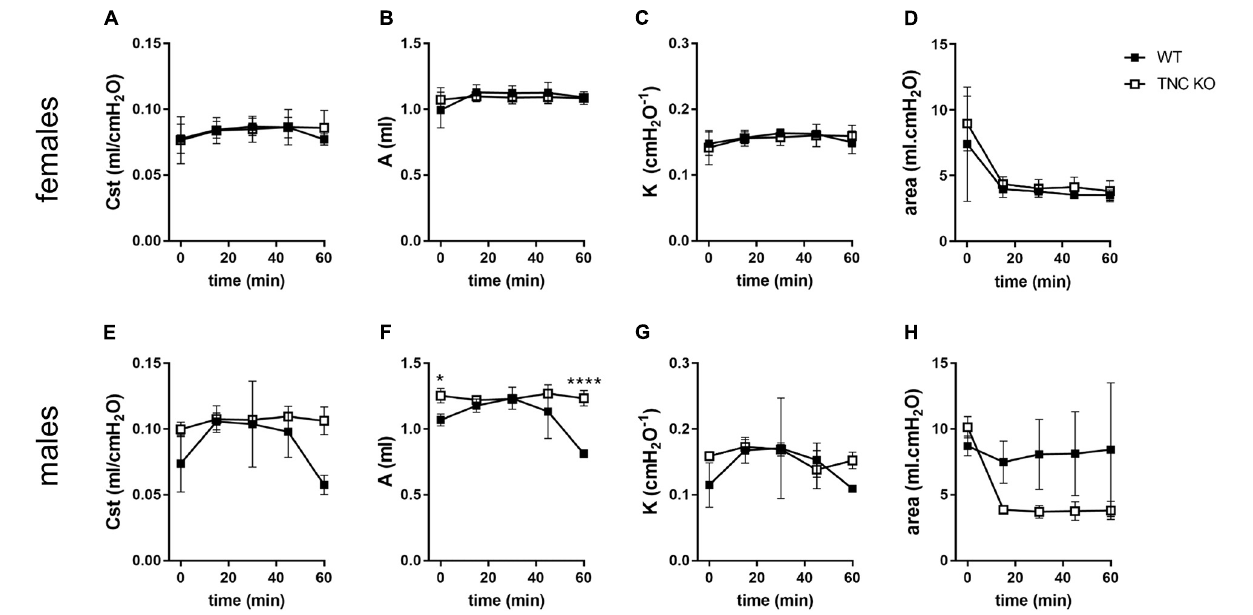
FIGURE 6 | Lung function in old TNC-deficient and WT animals. Respiratory function parameters were collected with the help of a flexiVent system under basal conditions (time 0) or during 1 h of HTV ventilation in old TNC-deficient ( (cid:3) ) and WT ( (cid:4) ) animals. (A,E) : static compliance (Cst), describing the distensibility of the respiratory system; (B,F) : parameter A, estimating the inspiratory capacity; (C,G) : parameter K, describing the curvature of the PV deflation curve; (D,H) : hysteresis, estimating atelectasis existing before the PV loop (area between the PV inflation and deflation limbs). N = 3–4 animals/gender and genotype. Results are expressed as mean ± SD. Statistical analyses were made by two-way ANOVA; statistical significance was set at p < 0.05; * p < 0.05, **** p <